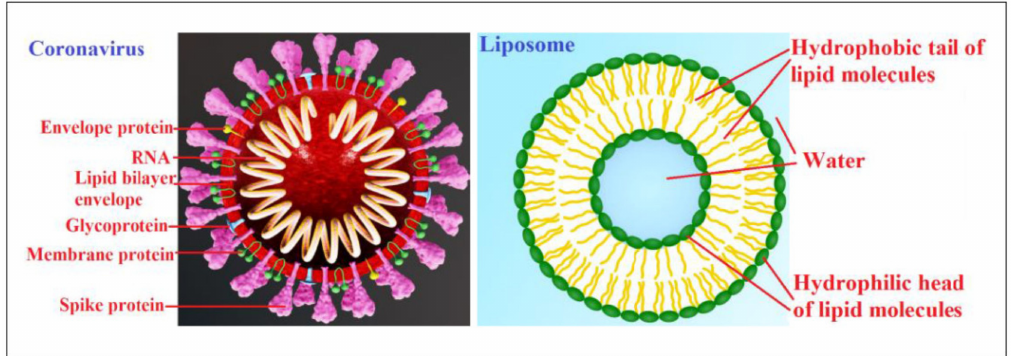
Figure 1. Schematic of an enveloped coronavirus and a liposome with a lipid bilayer membrane. Adopted from https: // en.wikipedia.org / wiki / Coronavirus and https: // es.wikipedia.org / wiki /